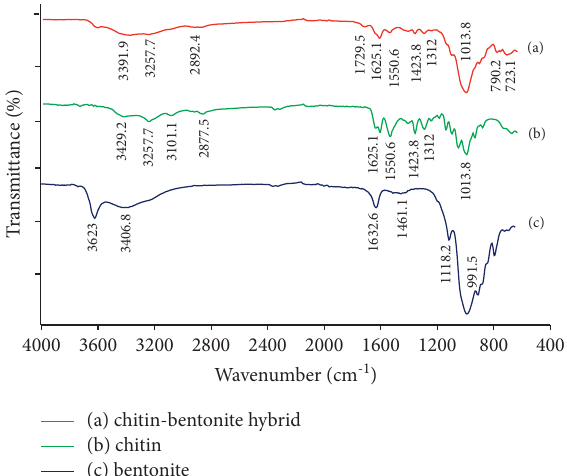
Figure 1: FT-IR spectra of chitin, bentonite, and CB hybrid materials. (a) Chitin-bentonite hybrid. (b) Chitin. (c)